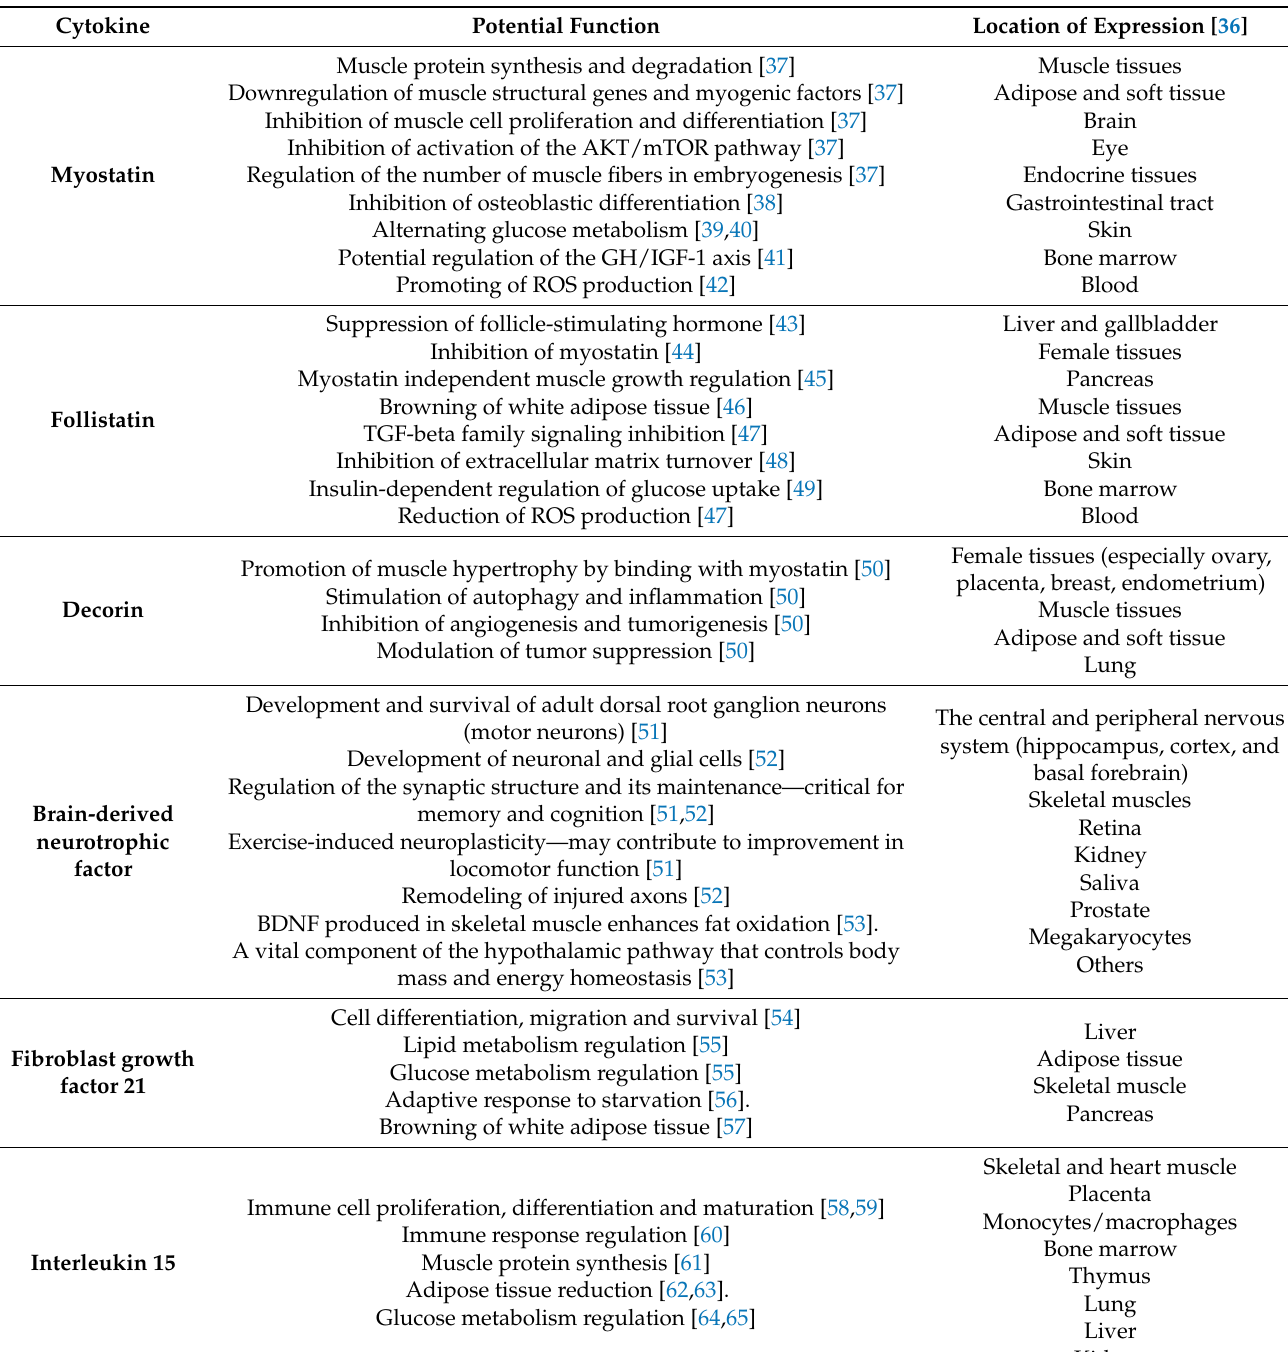
Table 1. Potential functions of selected cytokines and location of